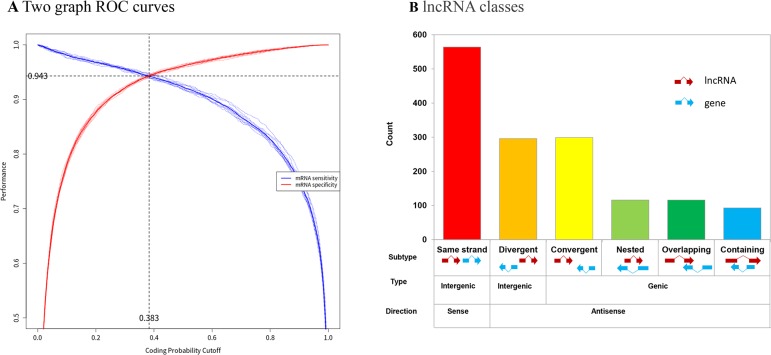
Identification of novel lncRNAs in Ae. albopictus. (A) Two ROC curves for automatic detection of optimized CPS threshold and user specificity threshold. Red line indicates mRNA specificity. Blue line indicates lncRNA specificity. (B) lncRNA classes based on RNA partners from reference annotations. Types and counts of novel lncRNA molecules in Ae. albopictus.